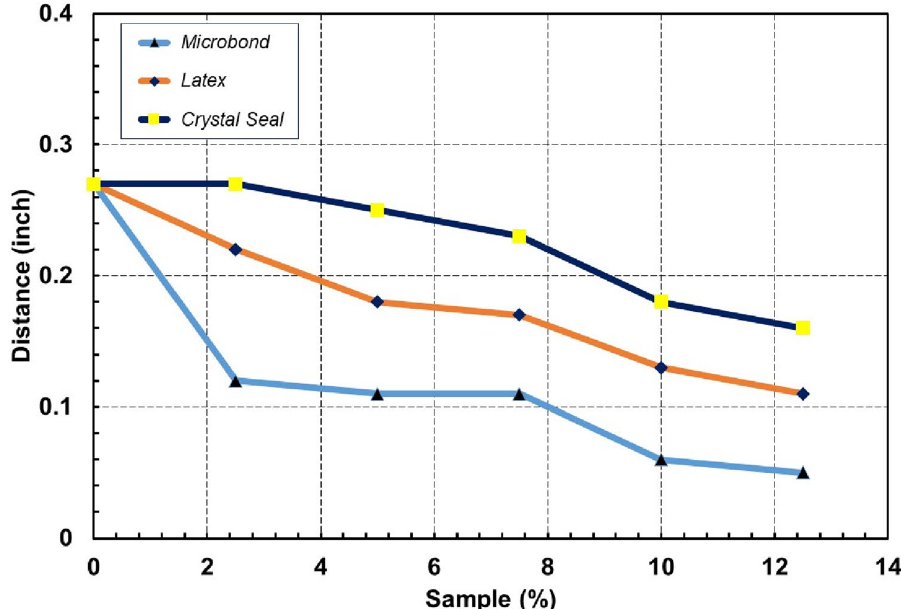
Fig. 19 Additives comparison,